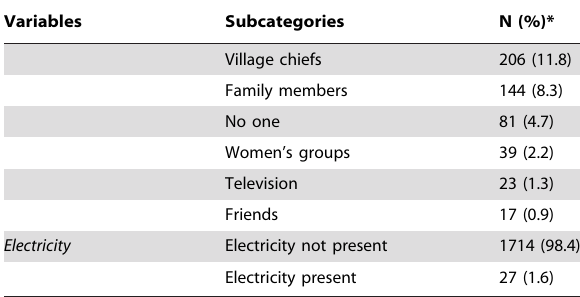
Table 1. Characteristics of caregivers of children 6–59 months who participated in the evaluation survey (N= 1741) and their